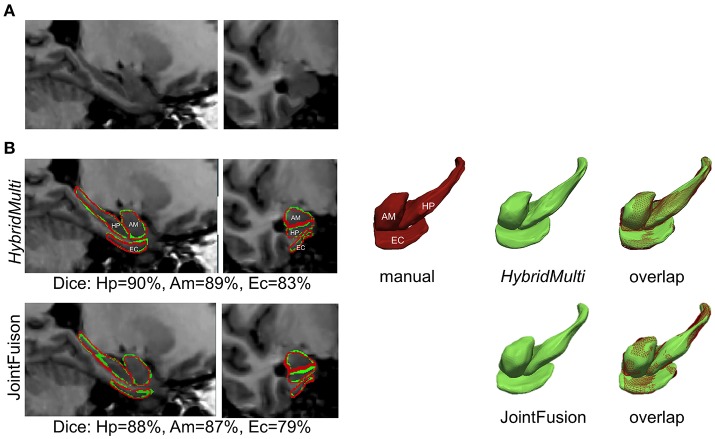
Segmentation of mesiotemporal lobe structures in a patient with atrophy. Shown are overlaps between two best algorithms (HybridMulti, JointFusion—green) and manual label (red). (A) MRI (B) Segmentations overlaid on MRI and in 3D rendering.